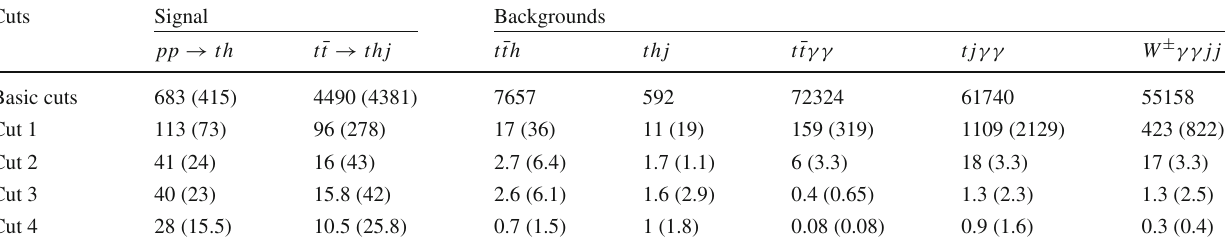
Table 3 The cut flow of the cross sections (in ab) for the signals and SM backgrounds at the FCC-hh with κ tuh = 0 . 04 and κ tch = 0 . 04 (in the